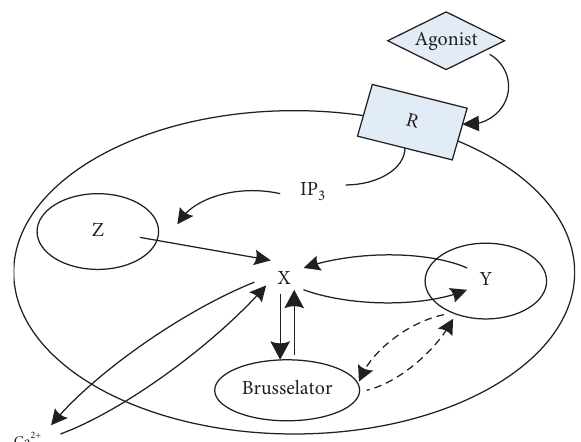
Figure 1: Schematic presentation of integration between the cell model and the Brusselator reactor. This illustration is from